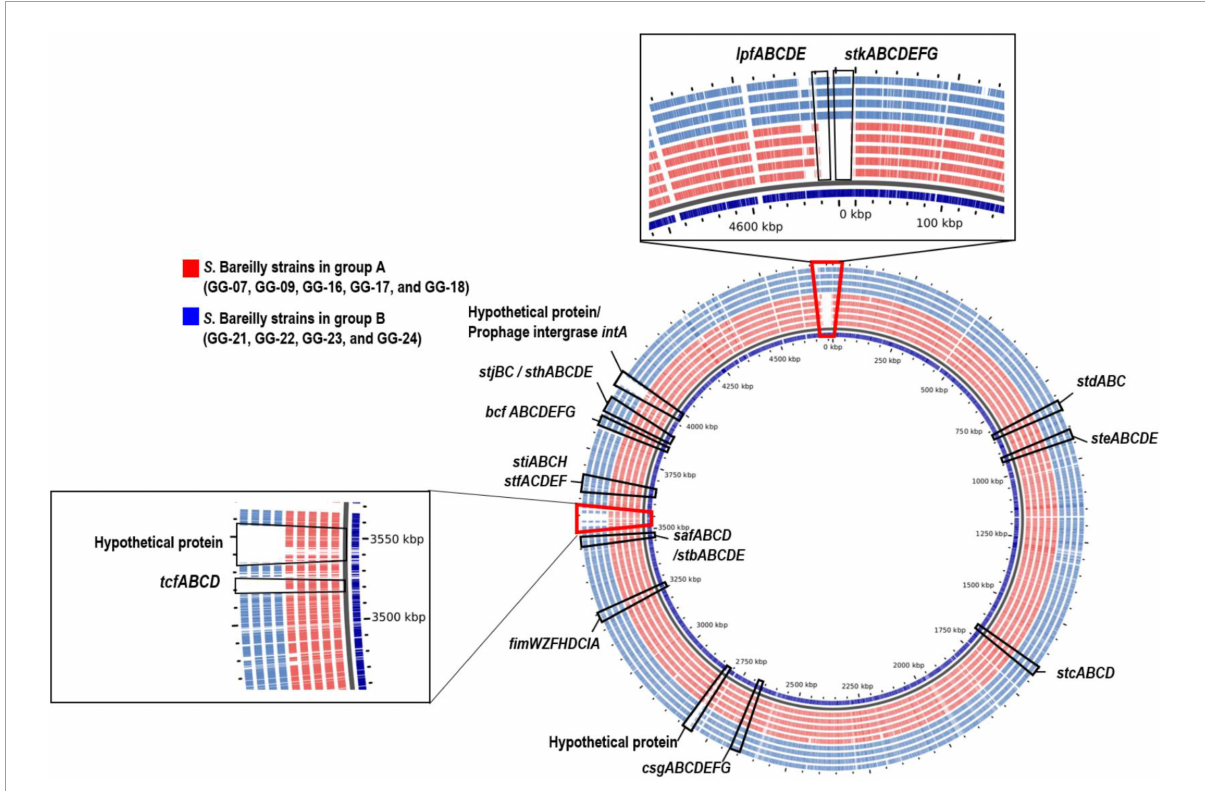
FIGURE3 Pangenome analysis of representative S . Bareilly strains isolated in South Korea. tcf (Typhi colonizing factor), lpf (long polar fimbriae), stk (putative fimbrial protein), csg (thin aggregative fimbreiae), fim (Type 1 fimbriae), bcf (bovine colonization factor), saf ( Salmonella atypical fimbriae), stb , stc , std , ste , stf , sth , sti , stj (putative chaperone-usher-dependent fimbrial